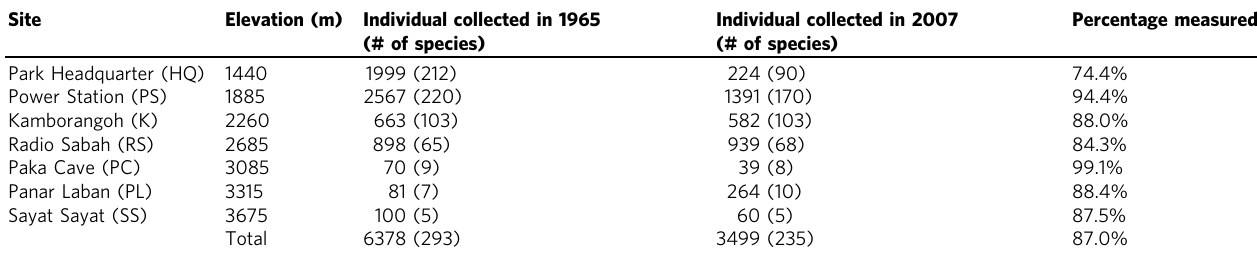
Table 1 Number of moth individuals and species collected or measured at the seven study sites Site Elevation (m) Individual collected in 1965 Individual collected in 2007 (# of species) (# of